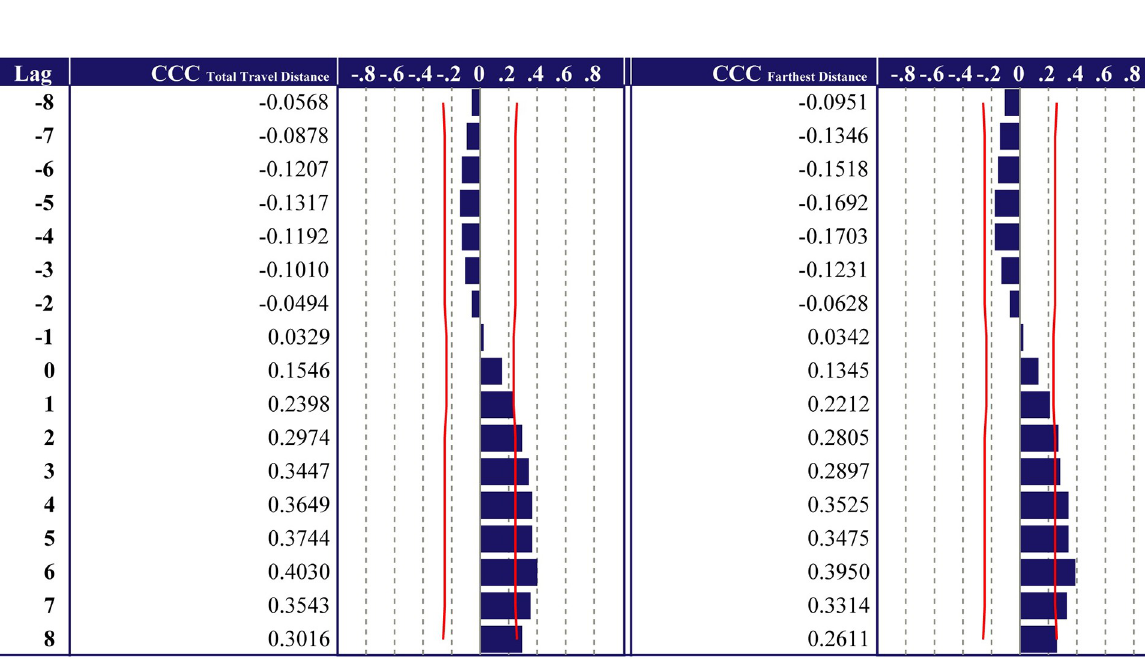
PLOS ONE | https://doi.org/10.1371/journal.pone.0267335 September 1,